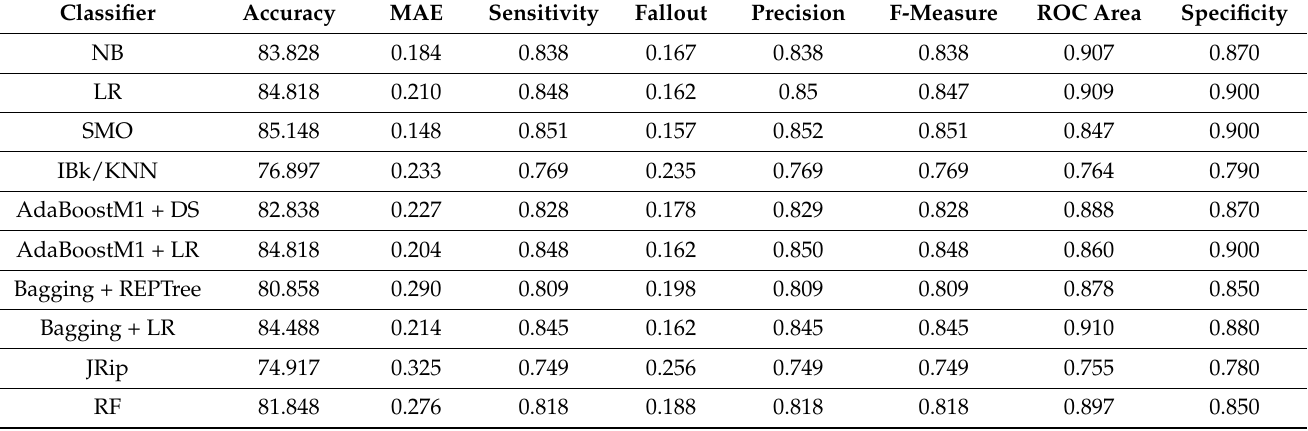
Table 7. Performance of machine learning classifiers based on the full set of attributes using 10-fold cross-validation.